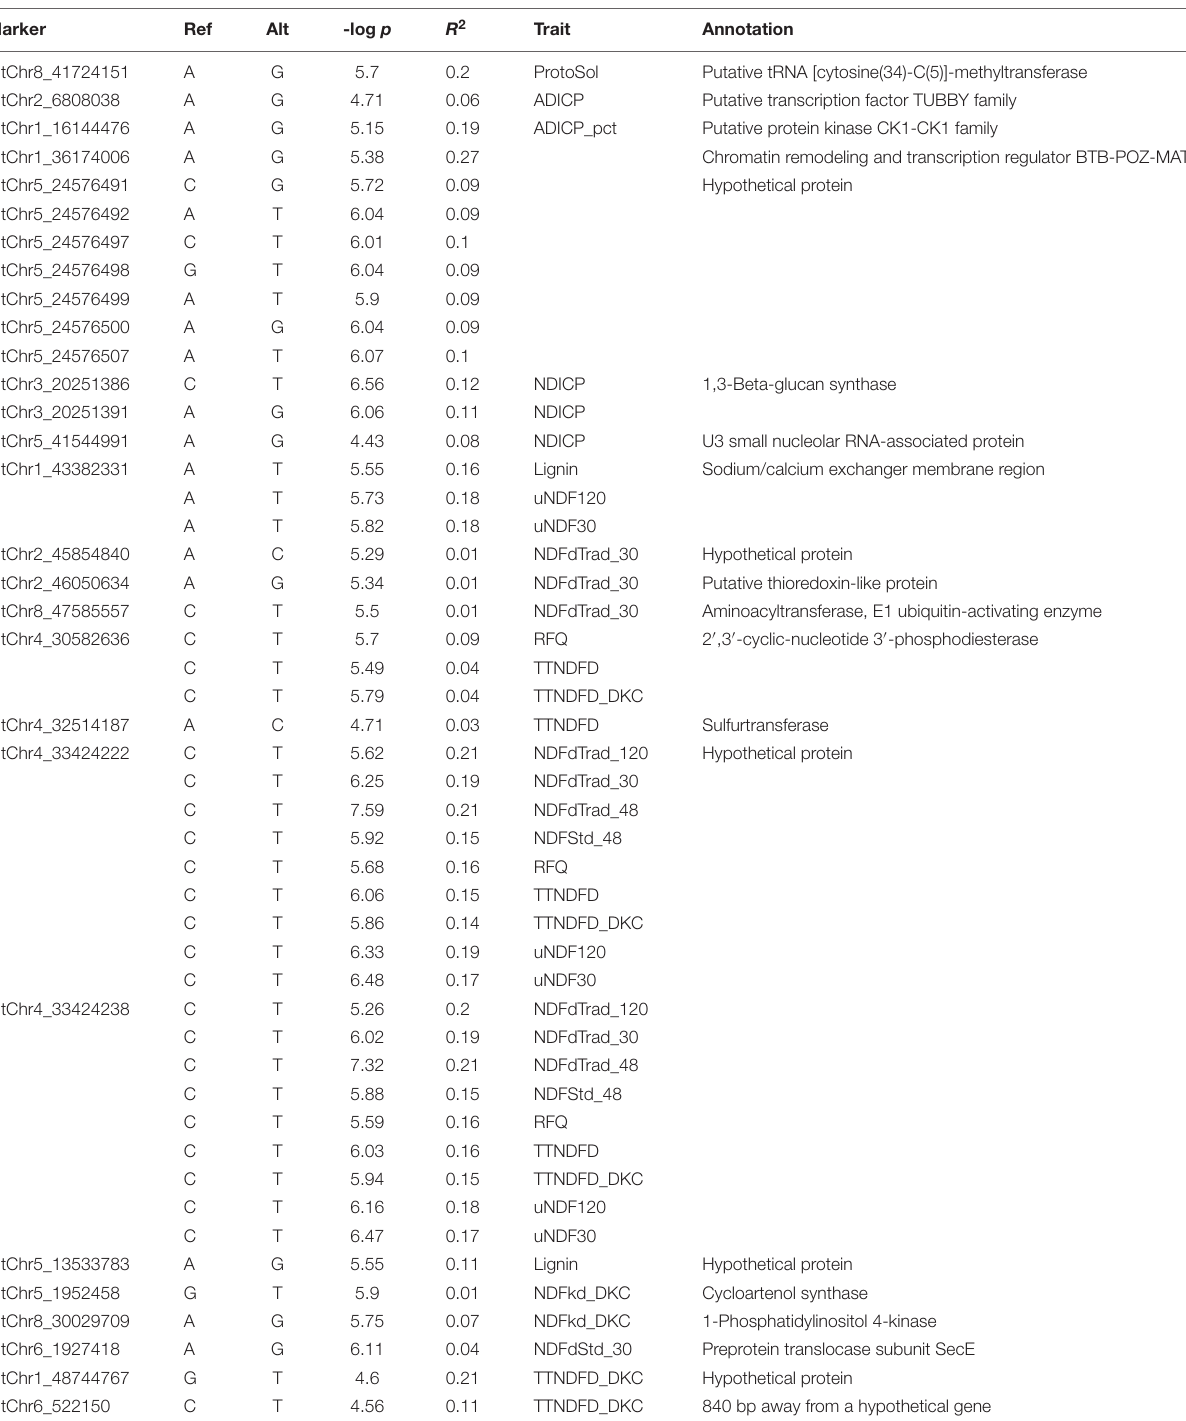
TABLE 2 | Significant markers associated with quality traits identified using M. truncatula genome as references. Marker